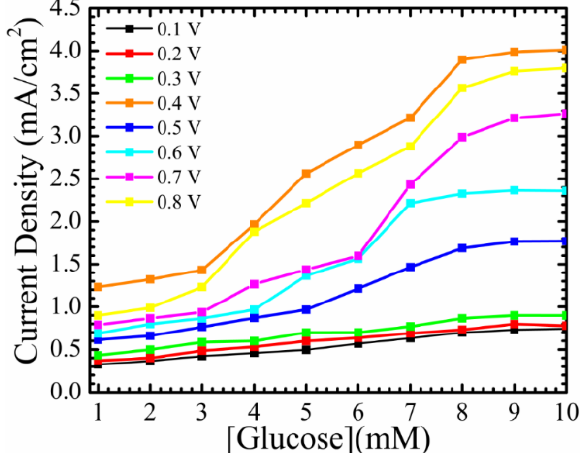
Figure 5. Current density of Si/SiO 2 /Au/ZnO NRs/GO x /Nafion as a function of different glucose concentrations at different applied potentials.